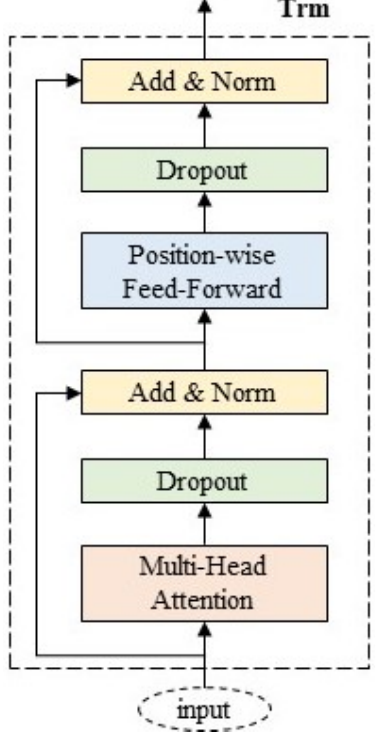
Figure 3. Transformer unit structure.